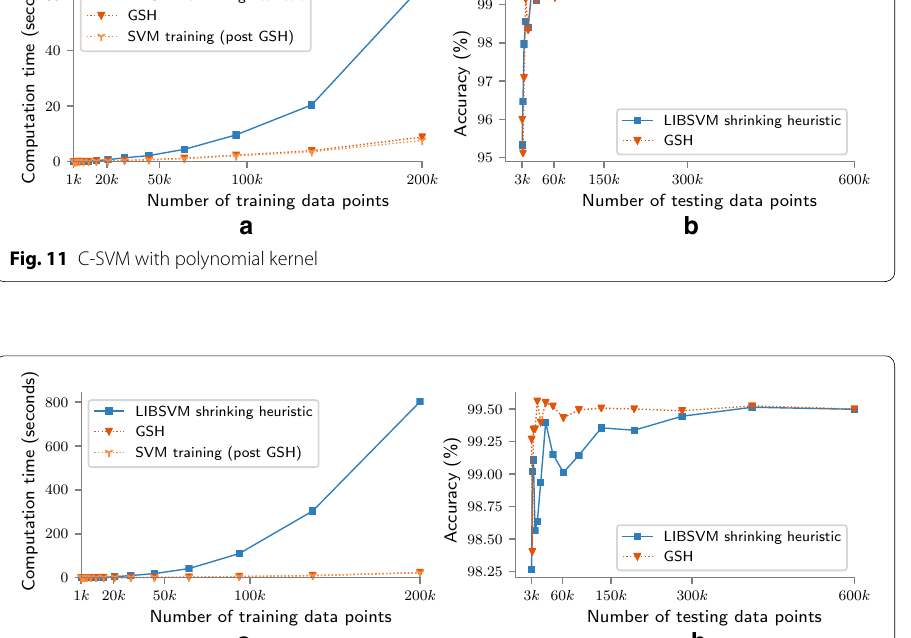
Fig. 12 nu-SVM with linear kernel